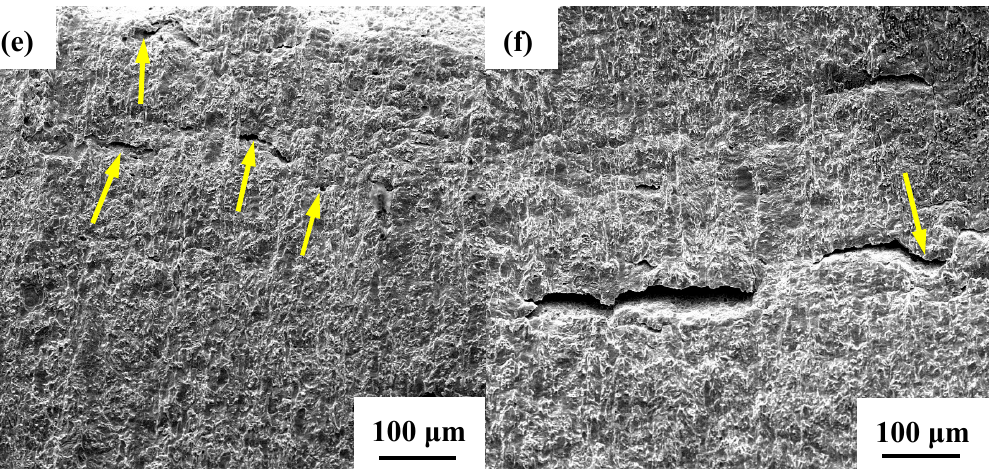
Figure 10. Side-surface morphologies of SSRT samples obtained at various conditions of ( a ) in air; ( b ) 0 A/m 2 ; ( c ) 10 A/m 2 ; ( d ) 30 A/m 2 ; ( e ) 50 A/m 2 ; and ( f ) 100 A/m 2 .